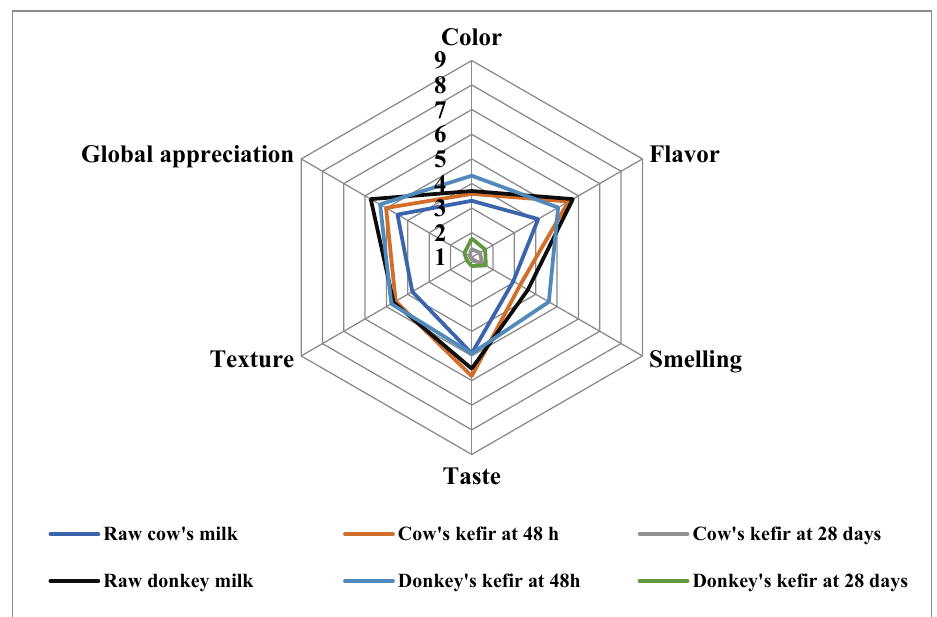
Figure 3. Sensorial profile of donkey’s and cow’s milk and kefirs.